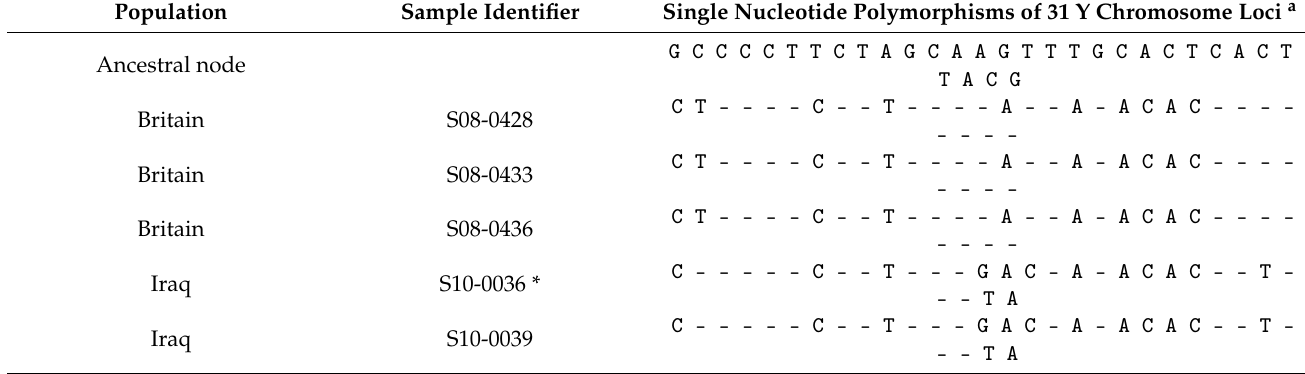
Figure 3. Red fox Y chromosome phylogeny displayed as a maximum likelihood tree inferred from 20,931 bp of sequence in 17 red foxes, 2 gray foxes, an island fox and 6 coyotes with node support inferred from 500 bootstrapped trees. Genetic distance was computed according to the Tamura 3-parameter model [27] and calibrated to divergence time in millions of years (MY). The locations of red fox samples are shown in Table 1. Table 1. Y chromosome haplotypes of 19 male red foxes and an ancestral node inferred from orthologous positions in Canis and Urocyon , which are composed of 31 variable sites, discovered 31,624 bp of the Y chromosome sequence. We also designed a genotyping assay for 13 of the loci (first 13 from left to right). Eighteen male red foxes were sequenced, including nine foxes that were also genotyped (*) and one fox that was genotyped but not sequenced (**). One locus (20_349AT) that was amplified in 14 of 19 females was excluded from this table. None of the other 13 genotyped loci was consistently amplified in females, although we observed a low (3.5%) false-positive rate. Genotype and sequencing calls matched 100% of the time. Two foxes that were genotyped but not sequenced (or not successfully sequenced, i.e., S12–1163) have missing data (X) across all non-assayed